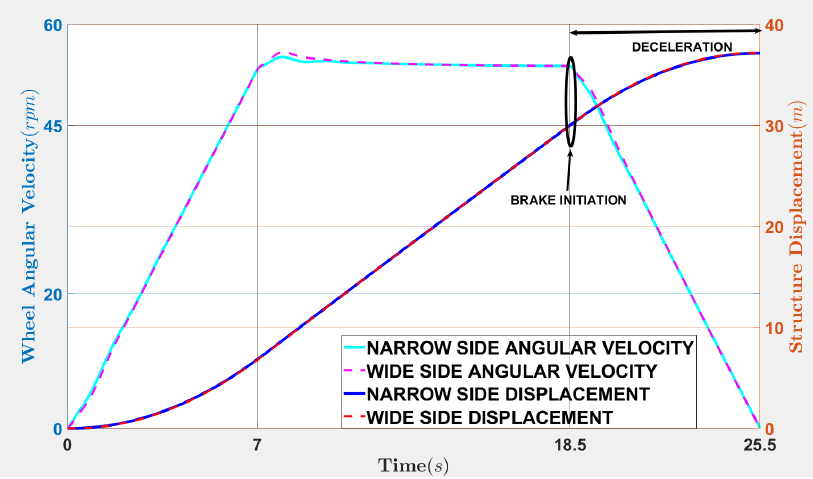
Figure 5. Wheel Angular Velocity and Displacement for the